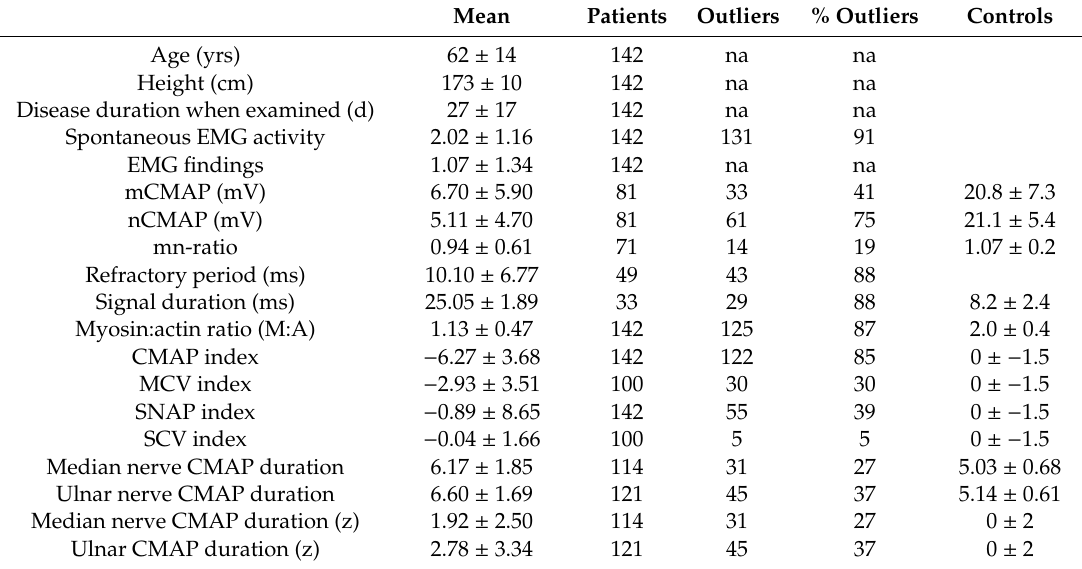
− 0.04 ± 1.66 6.17 ± 1.85 Ulnar nerve CMAP duration 6.60 ± 1.69 Median nerve CMAP duration (z) 1.92 ± 2.50 Ulnar CMAP duration (z) 2.78 ± 3.34 45 37 0 ±